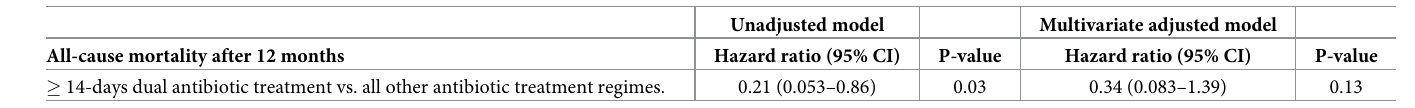
Table 3. Association between antibiotic treatment and all-cause mortality in post-hoc cox regression